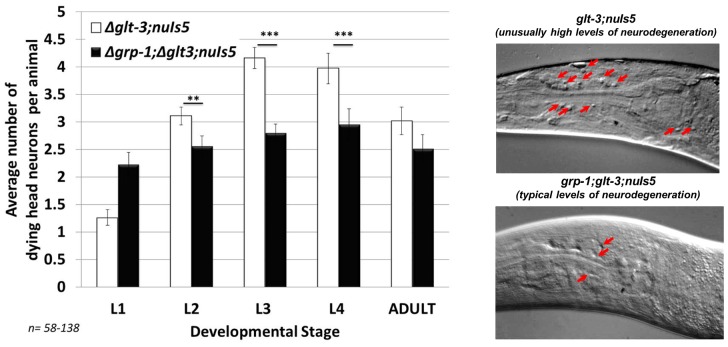
KO of grp-1, a GEF that stimulates Arf and PIP5K/PPK-1 to increase production of PIP2 substrate for the IIS cascade, provides neuroprotection.Left: a histogram showing a decrease in neurodegeneration upon KO of grp-1 (a second independent cross gave very similar distribution, not shown) **: p<0.05; ***: p<0.01. Right: Nomarski/DIC images of neurodegeneration in head neurons. Anterior left, dorsal top, the nerve ring area is shown (located between the two bulbs of the pharynx), red arrows indicate degenerating neurons. A typical level of neurodegeneration in our excitotoxicity strain was depicted previously [43]. We note that the extent of neurodegeneration varies among individual animals of the same genotype. Here, the upper image depicts an individual L3 animal from our excitotoxicity strain with an unusually high level of neurodegeneration. The extensive neurodegeneration seen in such untypical animals is evened out in the large number of animals used for each bar in our histograms (usually >90 animals in the most informative stages), bringing average neurodegeneration levels in our excitotoxicity strain (glt-3;nuIs5) to ∼4.5 dying head neurons/L3 animal. The bottom image depicts a typical grp-1;glt-3;nuIs5 L3 animal, a strain that typically shows 2–3 dying head neurons/L3 animal.